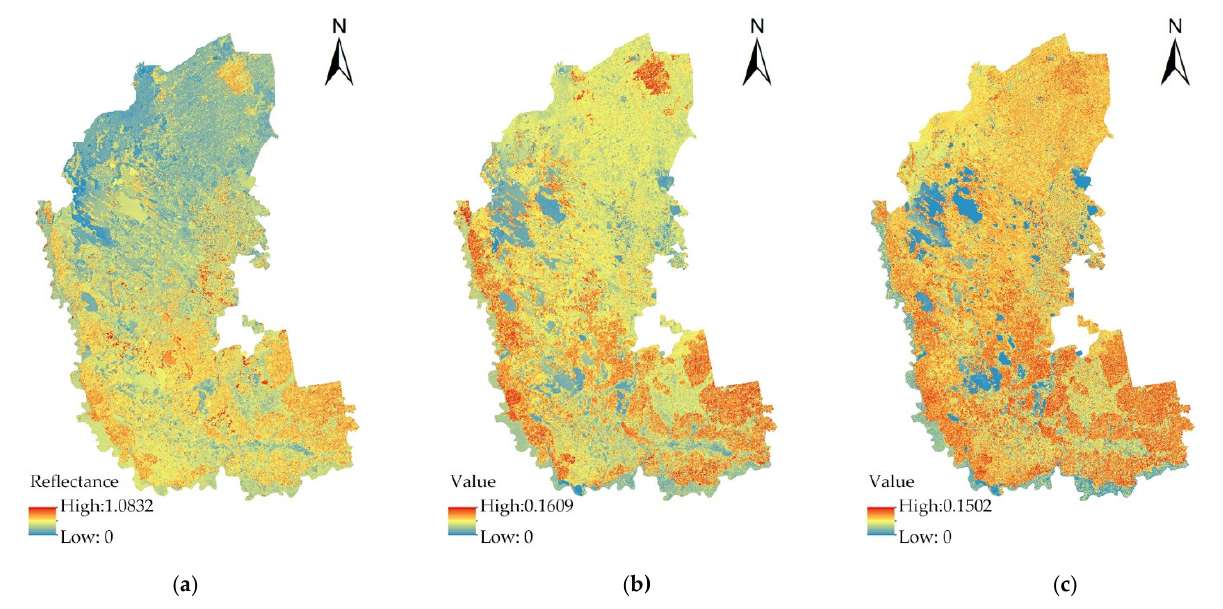
Figure 3. Derivative processing of remote image. ( a ) Original remote-sensing image; ( b ) First derivative processing of remote-sensing image; ( c ) Second derivative processing of remote-sensing image.